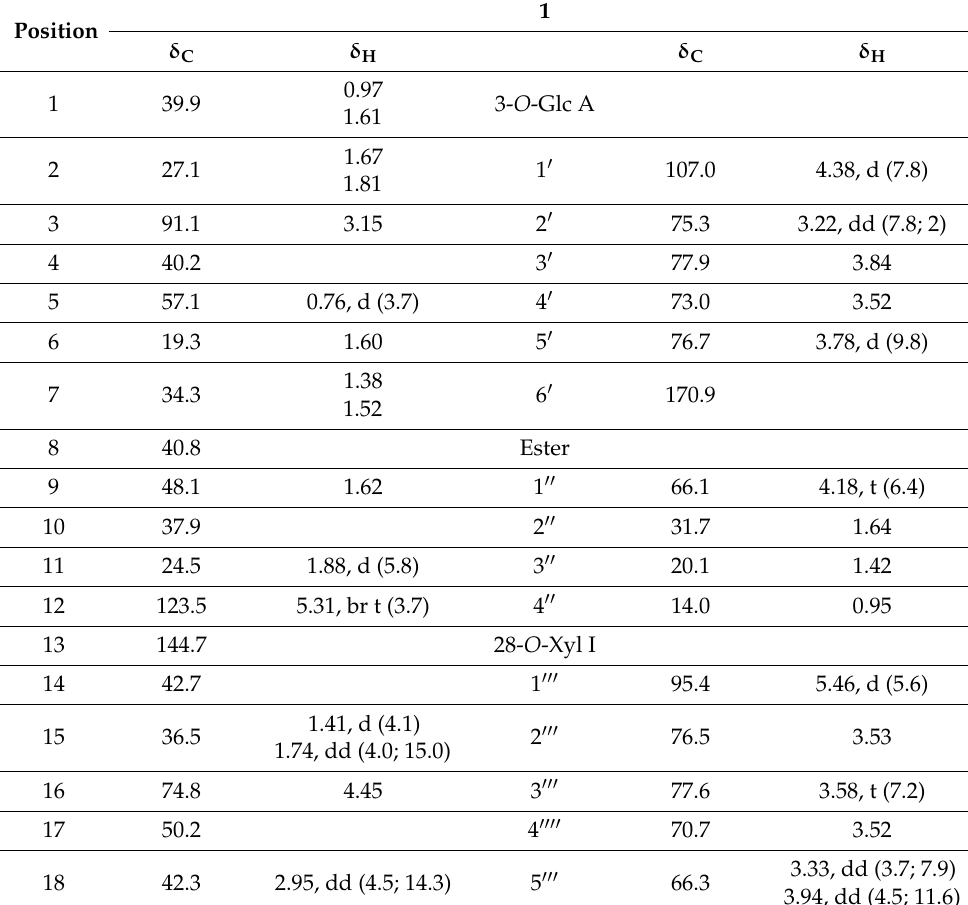
Table 1. 1 H and 13 C NMR data of compound 1 (600 and 150 MHz, CD 3